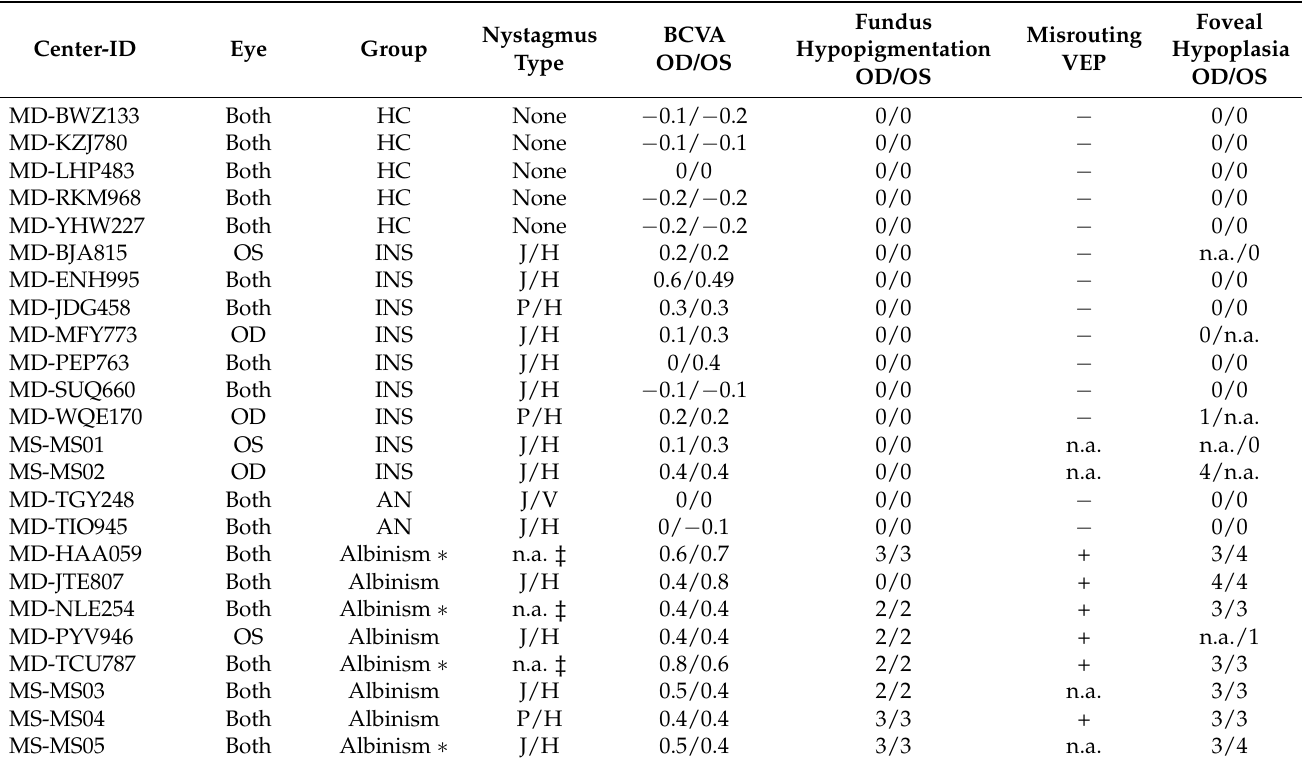
Table 1. Participants’ grouping and key features.